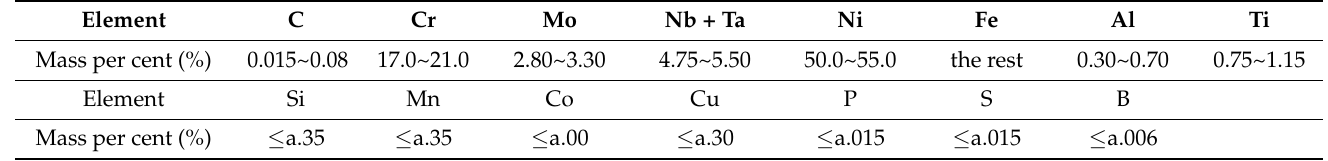
Figure 3. FE model of the vortex reducer and the disk (1/18 sector). Table 1. Chemical composition of high-strength GH4169